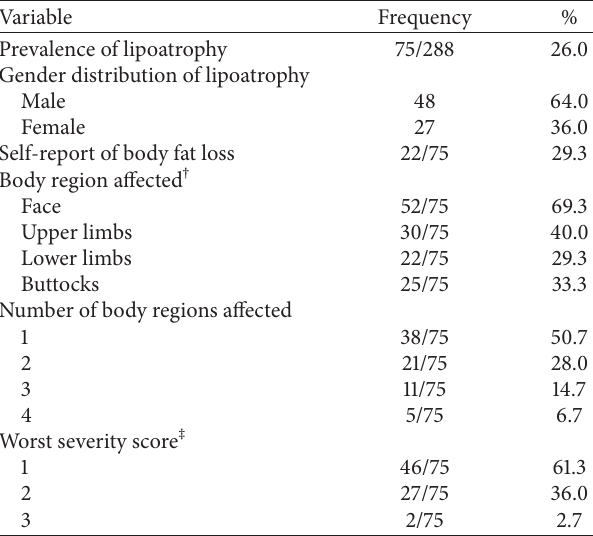
Table 3: Prevalence, self-report, and pattern of lipoatrophy in the study